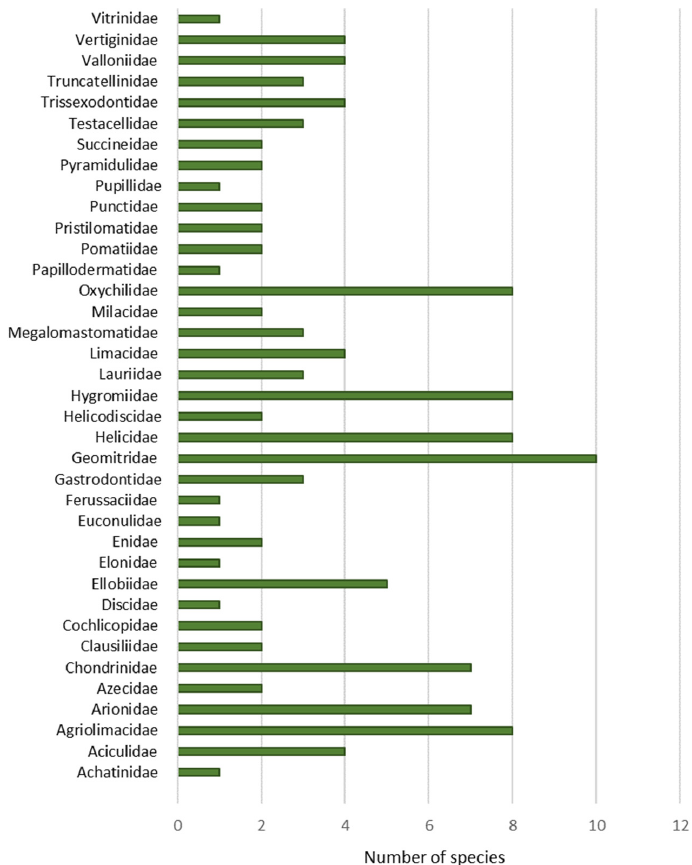
Figure 3. Diversity of species of the different terrestrial mollusc families recorded in Asturias.